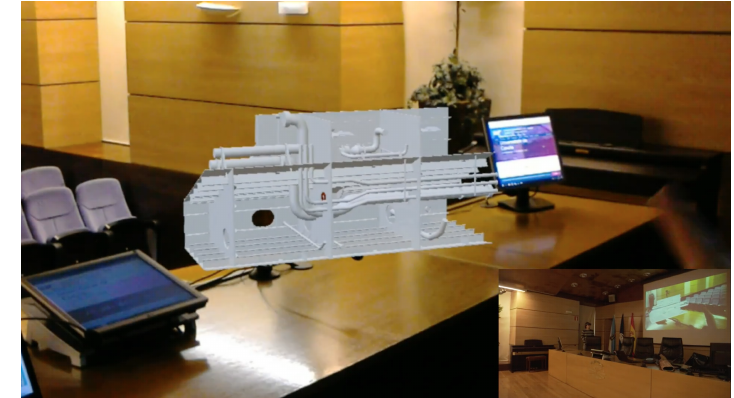
Figure 7. Ship block projected during a